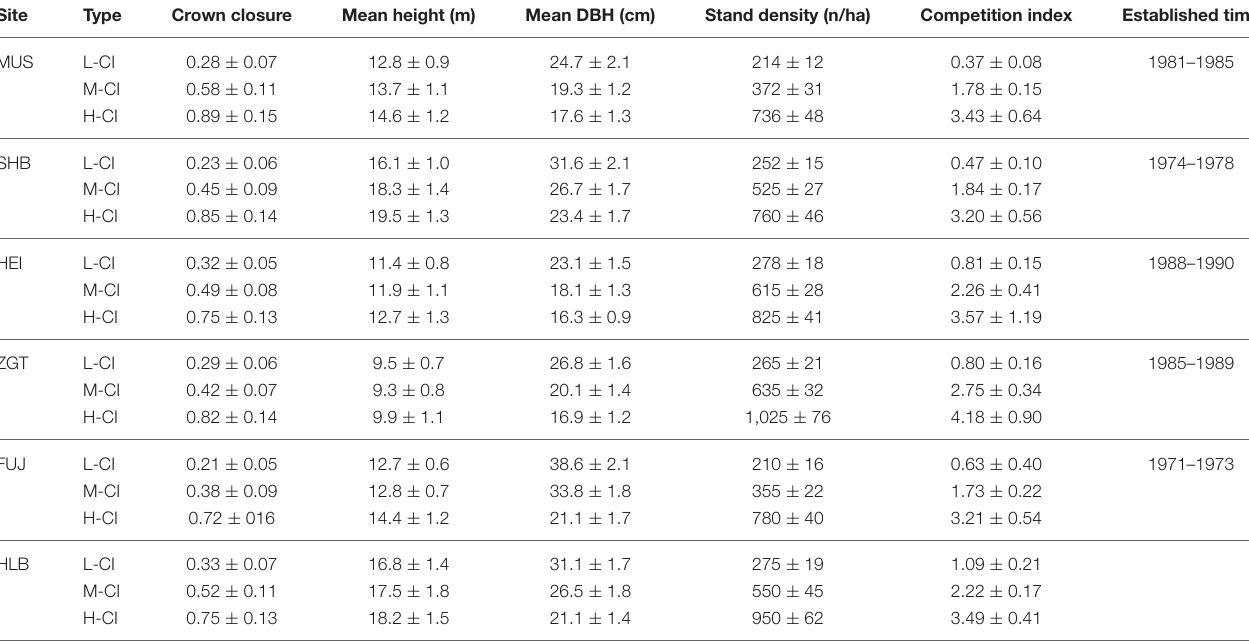
TABLE 1 | The statistical description of low-competition index (L-CI), medium-competition index (M-CI), and high-competition index (H-CI) stands of Mongolian pine at six experimental sites in the Three-North Shelter